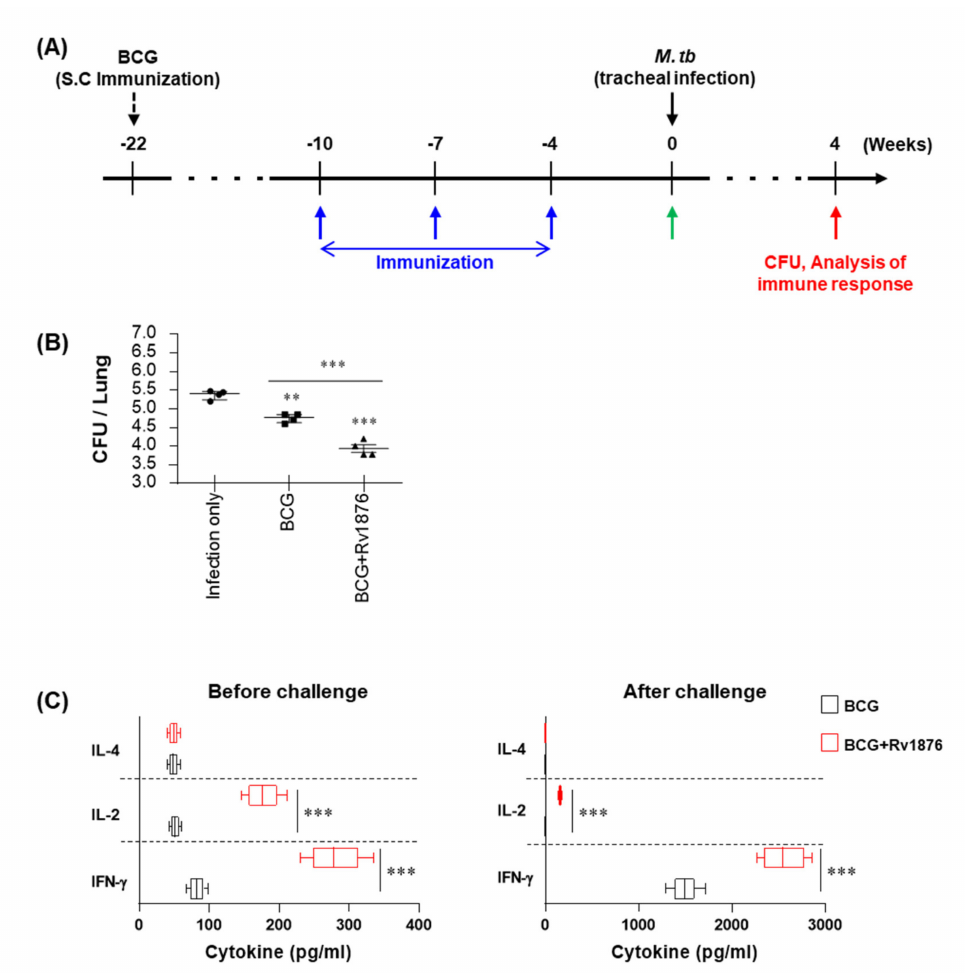
Figure 4. Rv1876/MPL-DDA booster vaccination improves BCG-primed protection against Mtb. ( A ) Experimental design for Rv1876 subunit vaccine testing. Mice ( n = 12 per group) were immunized by BCG injection 12 weeks before subunit vaccination. MPL-DDA were administered (blue arrows) before Mtb challenge (black arrow). Immunological analysis was conducted before (green arrow) and after Mtb infection (red arrow). Bacterial counts in each group were determined at the indicated time points after Mtb infection (red arrow). ( B ) CFUs in the lungs in all treatment groups at 4 weeks post-infection, determined by counting the viable bacteria. Data are from one of two independent experiments ( n = 4 mice per group at each time point). Mann–Whitney rank tests were used to compare groups. ** p < 0.01, and *** p < 0.001. ( C ) Levels of IFN- γ , IL-2, and IL-4 secreted by